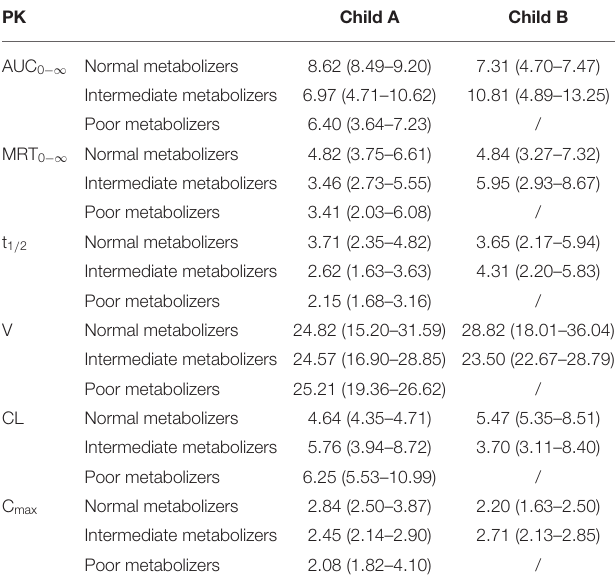
TABLE 5 | Comparison of esomeprazole pharmacokinetic parameters with various Child-Pugh grade and CYP2C19 metabolic phenotype. PK Child A Child